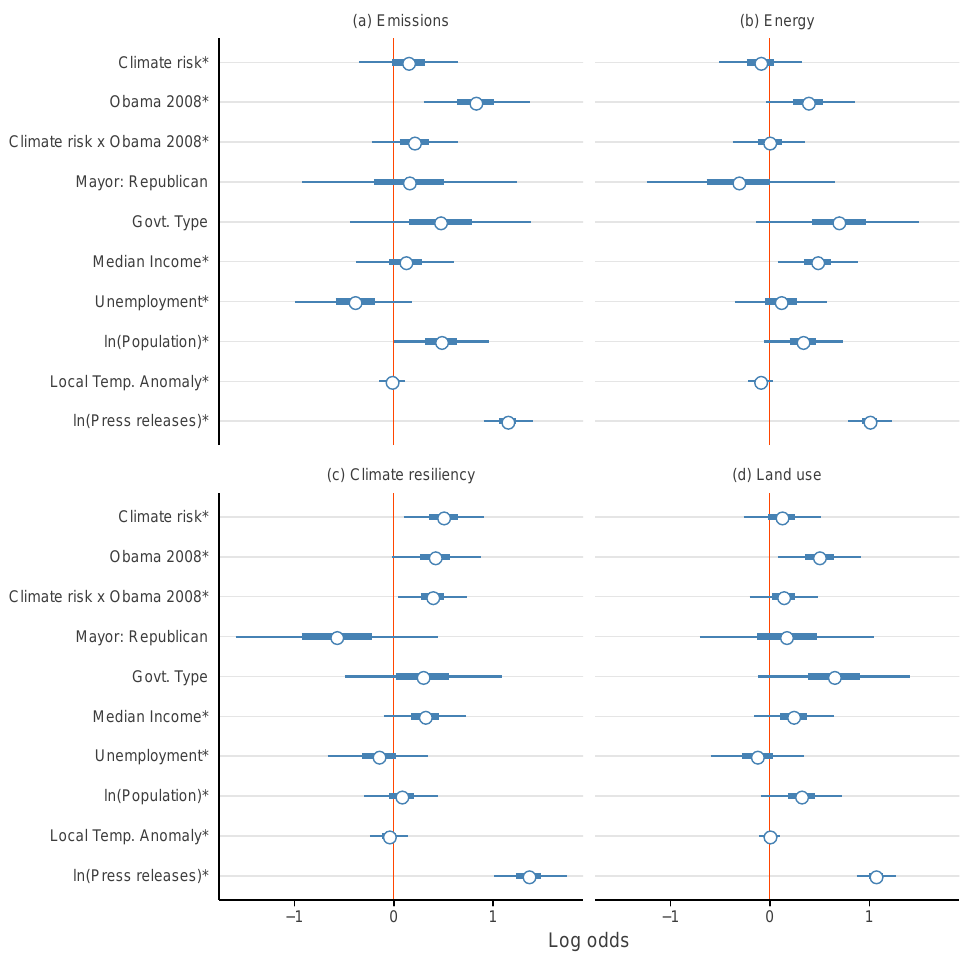
Figure 4. Explaining variation of climate-related themes in city press releases. This plot illustrates the results of a set of Bayesian multi-level logistic regression models, which estimate the effect of climate risk, political partisanship, and other covariates on whether a city discusses the following climate-related themes in a given month: ( a ) Emissions, ( b ) Energy (Energy efficiency & Renewable energy), ( c ) Climate resiliency, and ( d ) Land use. Circles represent posterior means, thick whiskers represent 50% credible intervals, and thin whiskers represent 95% credible intervals. Standardized variables are denoted with an asterisk